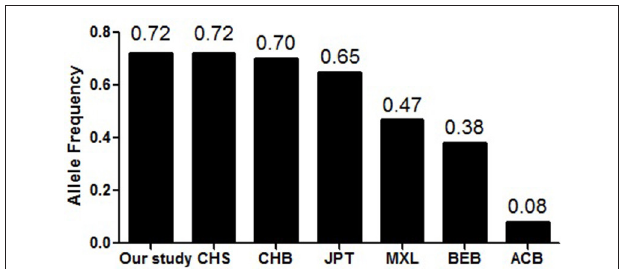
FIGURE 2 | Frequency distribution of the “T” allele of the rs3915512 in different ethnic groups. China. JPT, Japanese in Tokyo, Japan; MXL, Mexican ancestry from Los Angeles USA; BEB, Bengali from Bangladesh;ACB, African Carribbeans in Barbados. (This figure was based on the 1000 Genomes